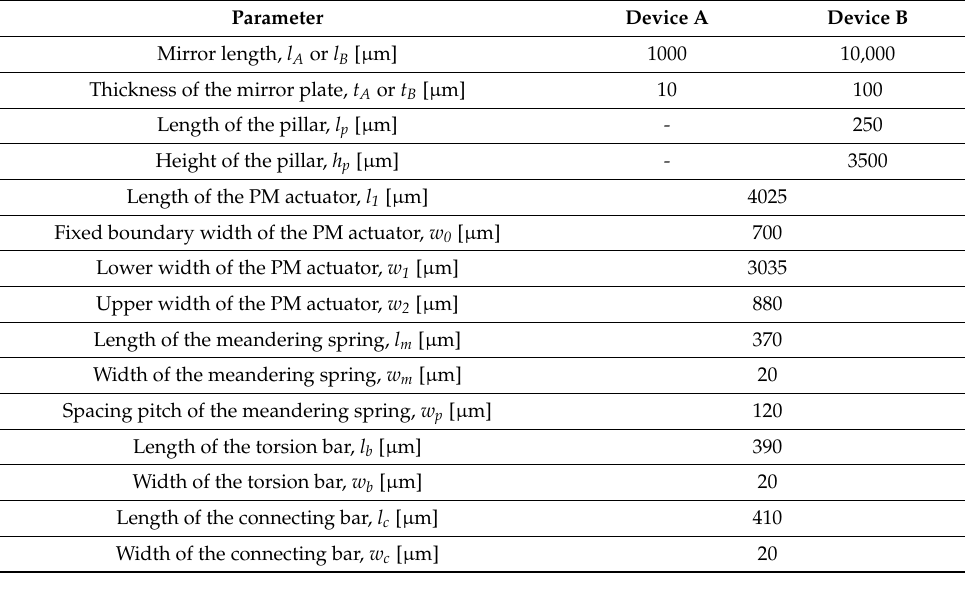
Table 2. Geometrical parameter specifications of mirror devices A and B.